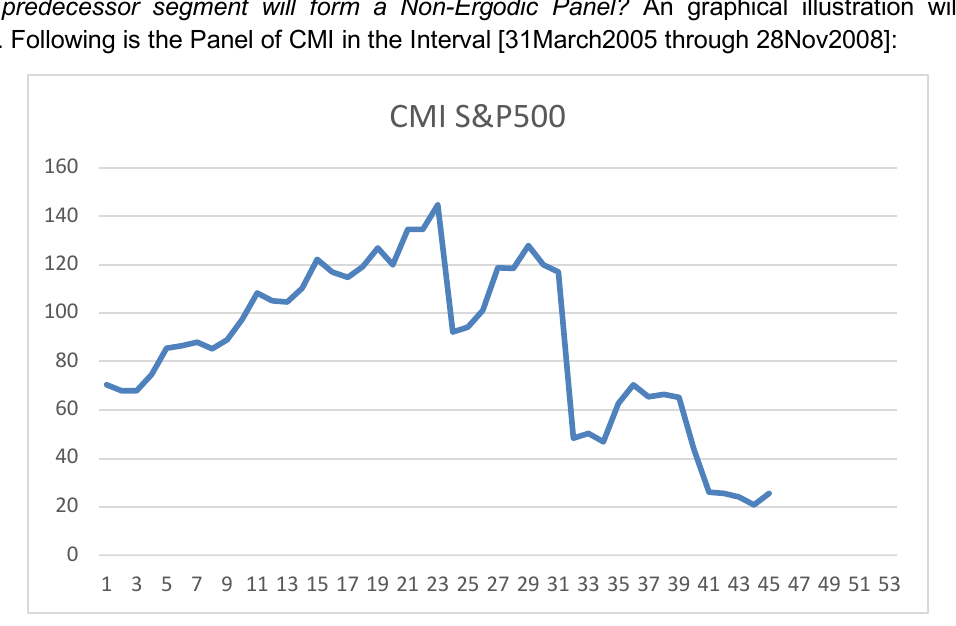
Figure 1 : Panel of CMI S&P 500 Monthly